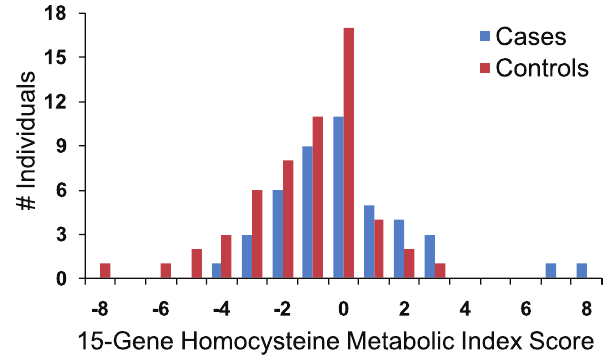
Figure 6. Homocysteine-Related Signature in Non-Hispanic Whites. Non-Hispanic white case/control distributions of homocyste- ine Metabolic Index Scores calculated from rare, non-coding variants (n=149) in 15 homocysteine-related genes, signed and summed according to Table S3. See text for details.